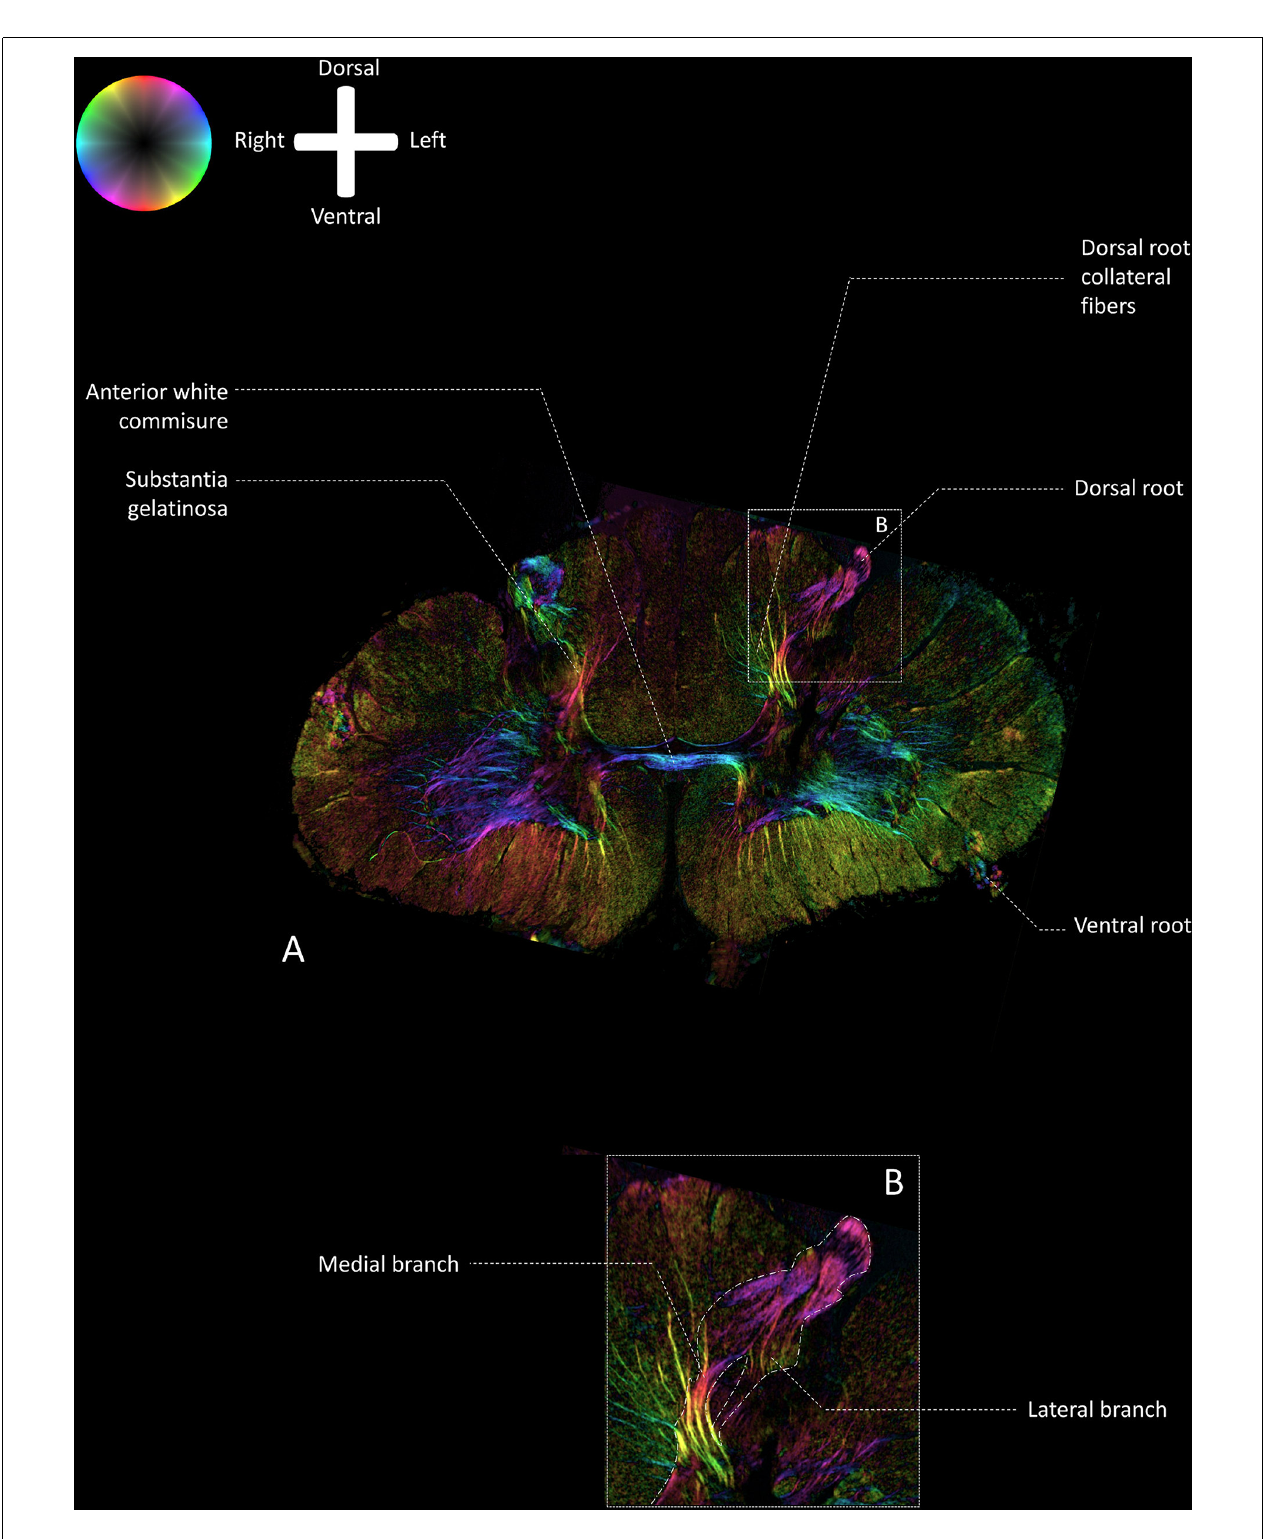
FIGURE 3 | Fiber orientation image of the a transverse section (100 µ m) at level C5–C6 of the cervical human spinal cord (specimen 2; similar section as depicted in Figure 2 ). The fiber orientation is defined by the color sphere and the intensity modulated by the density of in-plane myelinated fibers. (A) Overview of the white matter pathways in the cervical spinal cord. (B) Enlargement of inset in Panel A . The medial and lateral bundles of the entering dorsal root can be recognized. The lateral bundle can be seen as a low-intensity area, whereas the medial bundle can be followed up until the deeper layers in the dorsal horn.